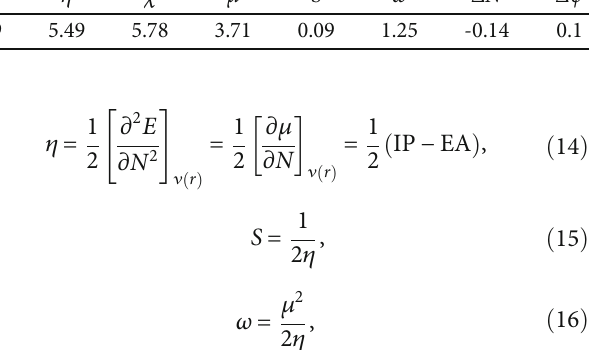
Figure 7: (a) Optimized structure of vanillyl alcohol according to DFT, (b) HOMO, and (c) LUMO. Table 6: Quantum chemical parameters for Vanillyl Alcohol obtained by DFT/B3LYP/6-311G (d,p) level. Inhibitor molecule E